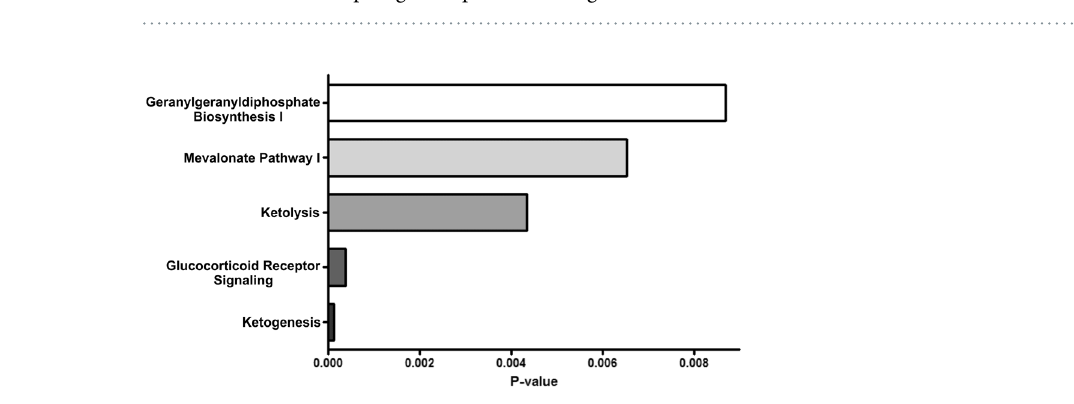
Table 1. Function of top 10 genes up- or down-regulated in T1D associated with CVD.